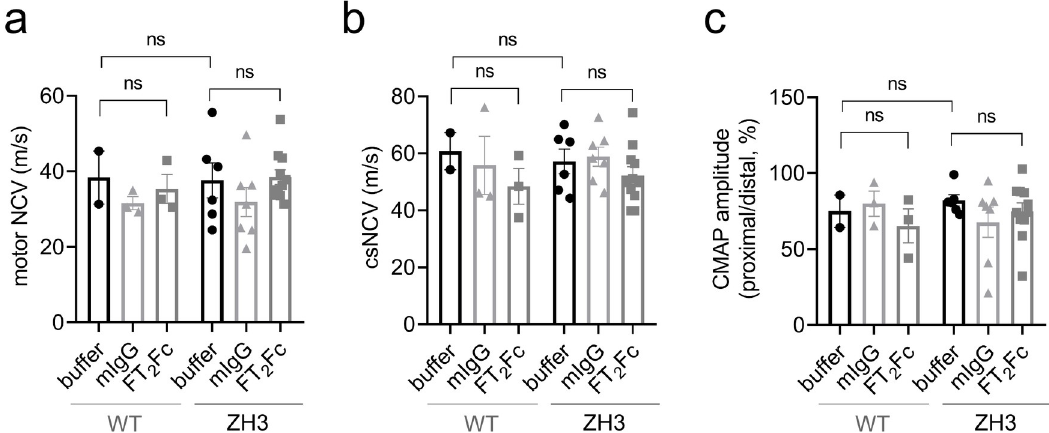
Fig 5. Electrophysiological studies. All tests and calculations were done with the examiners masked as to treatment and strain allocation. (a) Motor nerve conduction velocities (NCV) for WT and ZH3 mice. There was no significant difference between WT and ZH3 mice, or between FT 2 Fc treated and buffer treated mice (one-way ANOVA for indicated comparisons, Bonferroni’s multiple comparisons test, p > 0.05). (b) Compound sensory NCV (csNCV) for WT and ZH3 mice. Again, there was no significant difference between WT and ZH3 mice, or FT 2 Fc treated and buffer treated mice (one-way ANOVA for indicated comparisons, Bonferroni’s multiple comparisons test, p > 0.05). (c) The ratio of proximal to distal compound muscle action potential (CMAP) amplitude was not significantly different when comparing ZH3 to WT mice or FT 2 Fc to buffer treated mice (one-way ANOVA for indicated comparisons, Bonferroni’s multiple comparisons test, p > 0.05). ns = not significant.